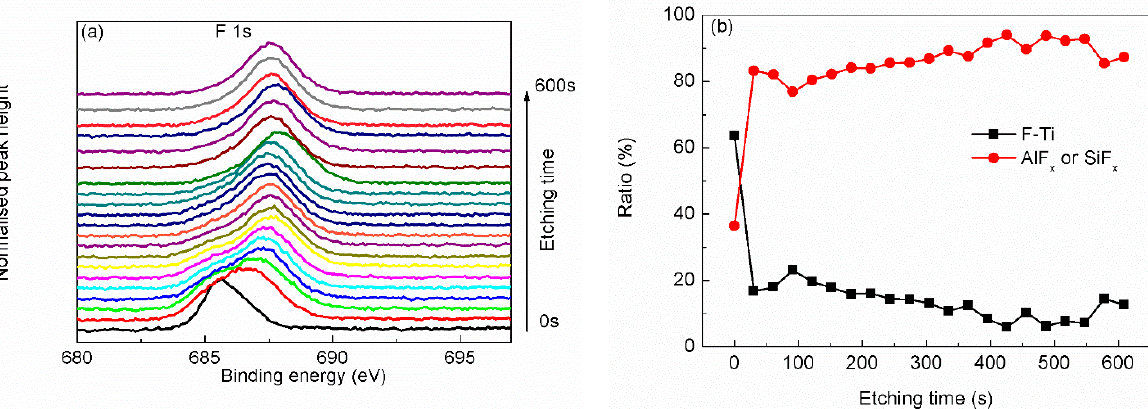
Figure 7. Narrow scanning depth profile ( a ) and state ratio depth profile ( b ) of F 1s.